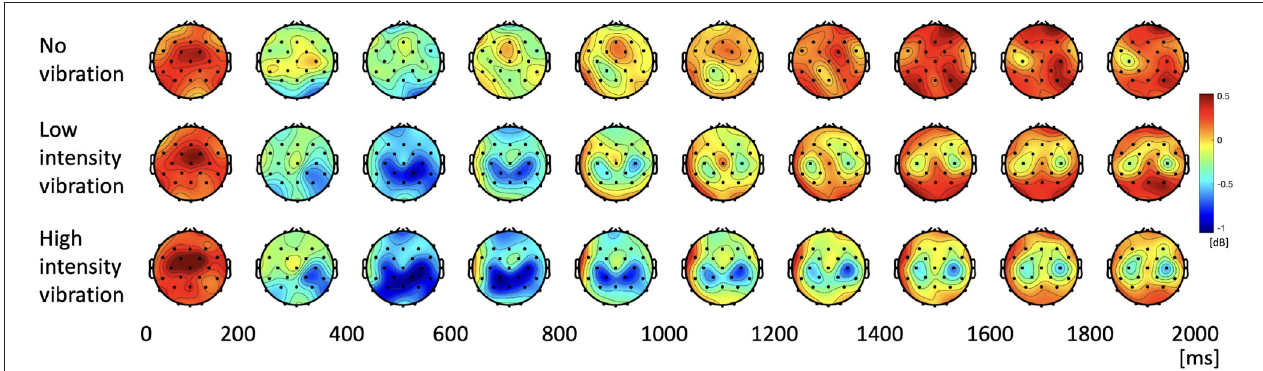
FIGURE 4 | Topographies of alpha power spectral density during the task period.